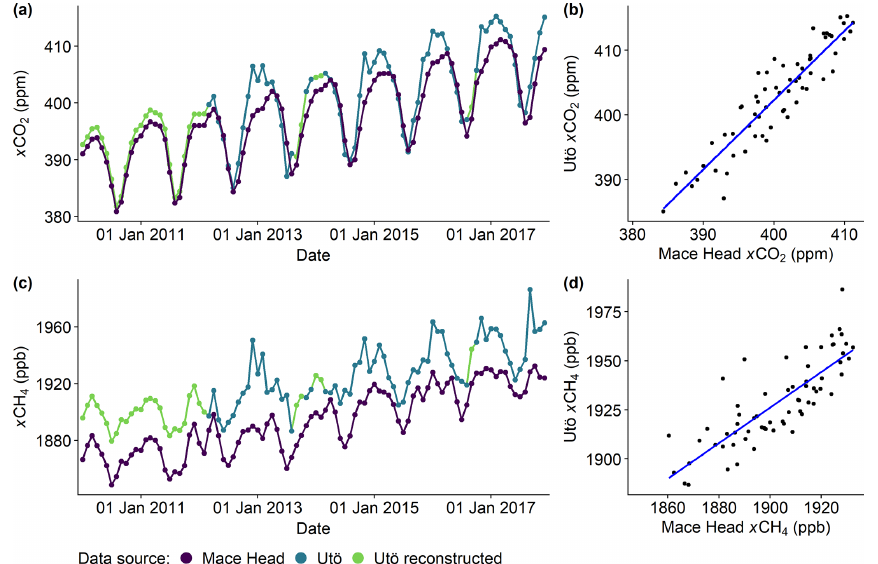
Figure A2. Monthly means of atmospheric (a) CO 2 and (c) CH 4 mole fractions from 2010 to 2017. We preferred data from Utö station (Finnish Meteorological Institute, Helsinki), which start in March 2012, due to their proximity to observations from SOOP Finnmaid . Concerning measurements on Utö, the method described in Kilkki et al. (2015) is applicable for the study period except that the Nafion dryer has not been in use since November 2013 (Juha Hatakka, personal communication, 2020). For the period before 2012 and to fill data gaps in September 2013 and 2016 in the Utö series, we used atmospheric data from Mace Head station (National University of Ireland, Galway) via the NOAA ESRL carbon cycle cooperative global air sampling network (Dlugokencky et al., 2019a, b), which is roughly at similar latitude. To correct differences between both stations, we normalised the data from Mace Head to those from Utö based on the shared period from 2012 to 2017 using linear regression (b, d) . This very simple approach is sufficient to evaluate the magnitude of super- and undersaturation and compare it on interannual